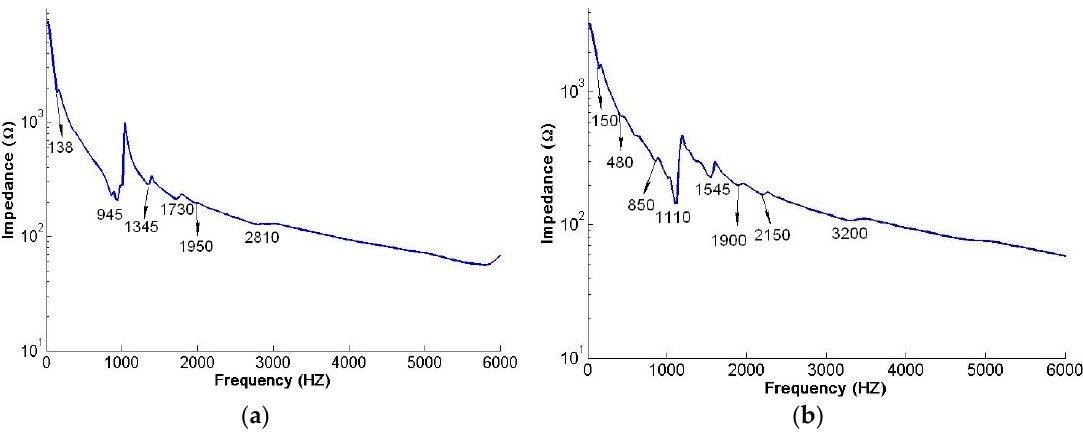
Figure 15. Impedance variation curve of water-coupled ( a ) anti-phase vibration and ( b ) in-phase vibration.